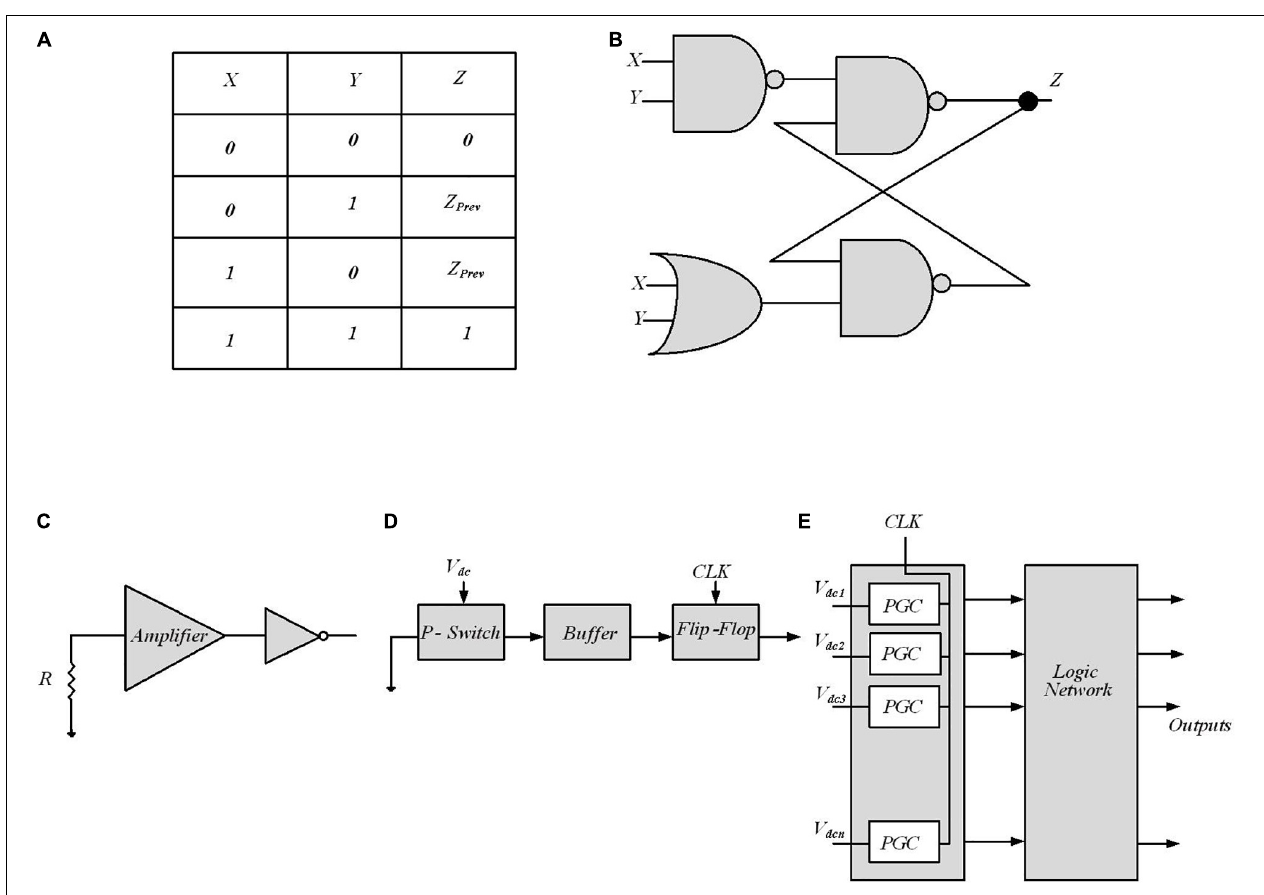
FIGURE 9 | Digital implementation of Bayesian inference. (A) Muller C-element truth table in Friedman et al. (2016). (B) Standard cell C-element design of Muller C-element. PCMOS-based Bayesian network in Weijia et al. (2007). (C) p-switch circuit implementation block. (D) Probabilistic generating cells (PGCs) block. (E) The inference system utilizes a probabilistic generating block and a logic